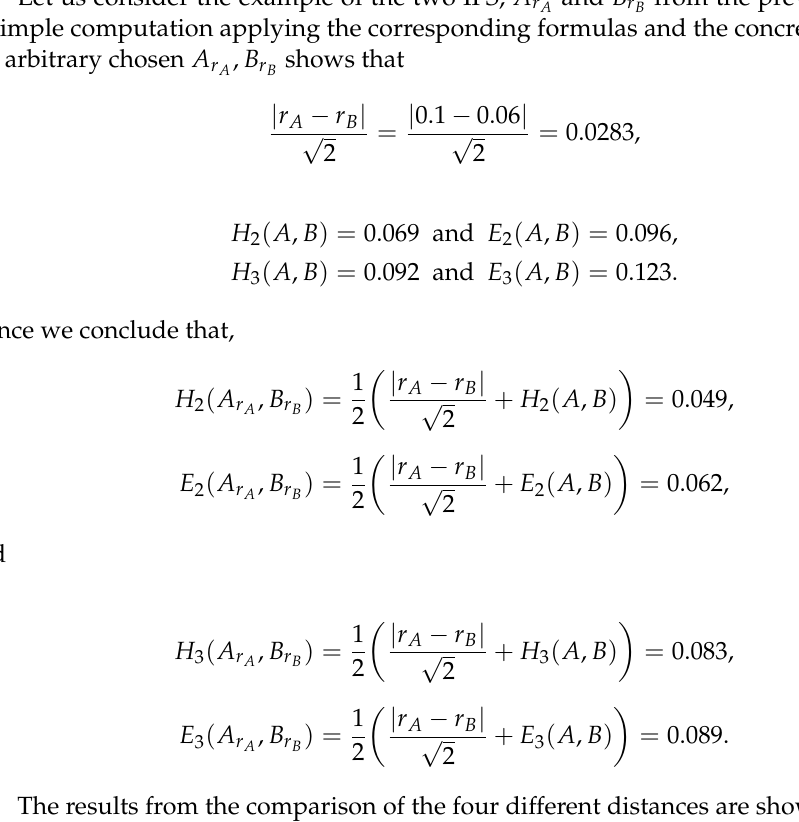
Figure 3. Triangular representation of A r r B = 0.06.